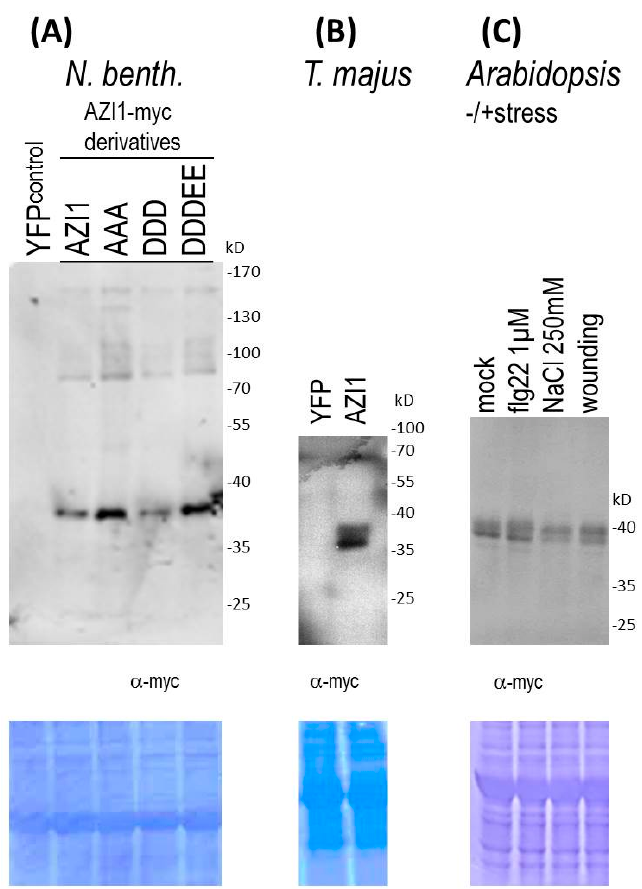
Figure 2. AZI1 gel retardation is MAPK-, plant species- and stress-independent. Transient expression of AZI1-myc in N. benthamiana ( A ) and T. majus ( B ). Leaves were infiltrated with agrobacteria carrying the respective constructs. Proteins were extracted five days after infiltration, separated by SDS-PAGE and detected by immunoblot analysis with anti-myc antibody. Differences in signal intensity between AZI1 derivatives (panel A ) likely result from position effects/transformation efficiency, not from altered protein stability; ( C ) Arabidopsis seedlings stably expressing the AZI1-myc transgene were exposed to stress prior to immunoblot analysis. Upper panels: Anti-myc detection; lower panels: Membranes after subsequent staining with Coomassie brilliant blue for documentation of protein loading.